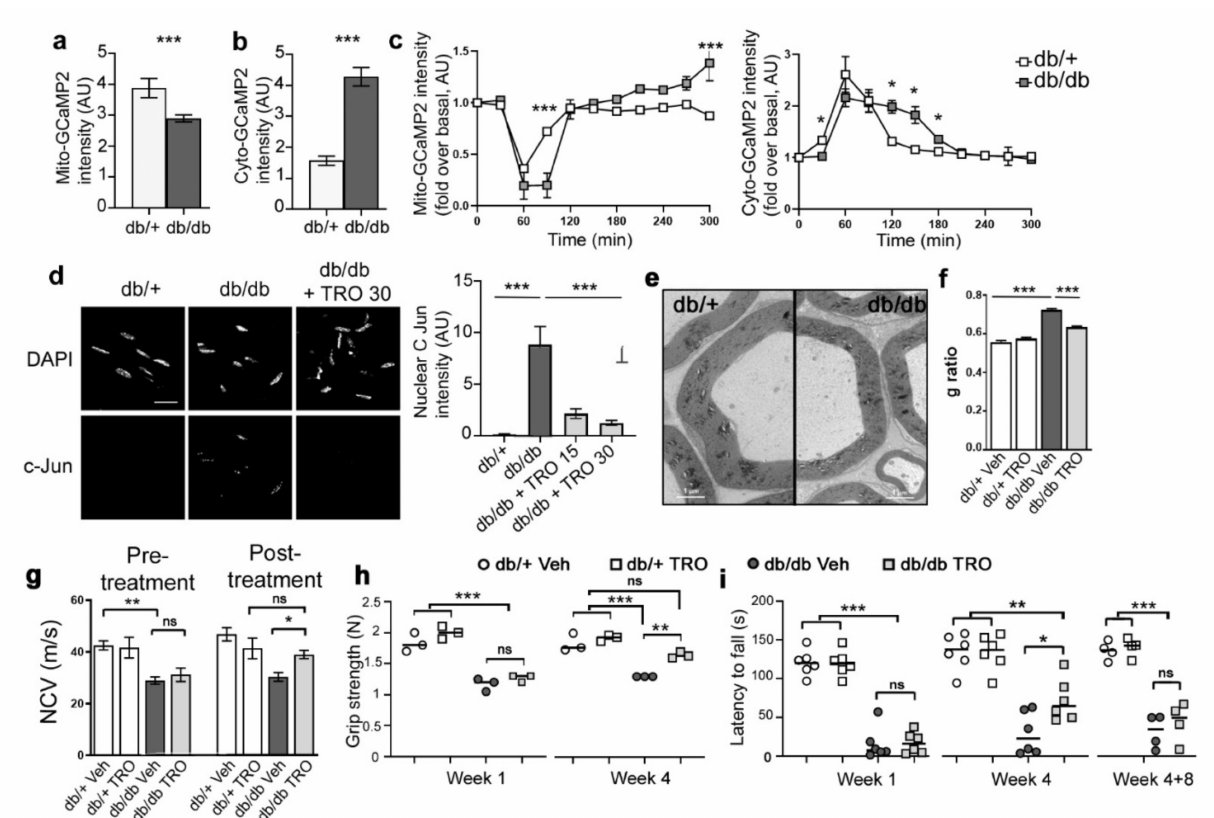
Figure 7. SCs of db/db diabetic mice show an altered mitochondrial calcium homeostasis and TRO19622 prevents motor, electrophysiological and cellular defects in these mice. Mitochondrial calcium (Mito-GCaMP2) ( a ), cytoplasmic calcium (Cyto-GCaMP2) ( b ) probe intensity in mSCs of control ( db/+ ) and diabetic ( db/db ) mice in basal conditions. Mitochondrial calcium is decreased and cytoplasmic calcium increased in the mSCs of diabetic mice. Error bars indicate SEM. Statistical tests are unpaired Student’s t -test. ( a ) n = 77 ( db/+ ), 168 ( db/db ) mitochondria (6 animals each genotype). ( b ) n = 11 ( db/+ ), 9 ( db/db ) mSCs (3 mice each genotype). All mice were 8 to 11 weeks old. ( c ) Mito- chondrial calcium (left) and cytoplasmic calcium (right) probe intensity in mSCs of control ( db/+ ) and diabetic ( db/db ) mice following nerve crush (t = 0). Mitochondrial calcium release is significantly sustained at t = 90 min. The probe fluorescence intensity is normalized over the basal condition before crush. Error bars indicate SEM. Statistical tests are two-way ANOVA Sidak post hoc test. Left: n = 40 ( db/+ ), 88 ( db/db ) mitochondria (3 mice for each genotype). Right: n = 7 ( db/+ ), 5 ( db/db ) mSCs (3 mice for each genotype). All mice were 8 to 11 weeks old. ( d ) Left panel: Immunohistochemistry for phospho–c-JUN and DAPI nuclei staining on mouse sciatic nerve cryosections. Mice were treated with vehicle (db/+, db/db ) or with TRO19622 ( db/db + TRO 30, 3 mg/kg) for 30 days. Arrows indicate infected mSC nuclei. Scale bar: 50 µ m. Same magnification for all pictures. Right panel: Quantifica- tion of nuclear phospho–c-JUN represented as fold over db/+ mice. Noninfected neighbour cells were used as internal controls. Mice were treated with vehicle (db/+, db/db , 30 days) or with TRO19622 for 15 days ( db/db + TRO 15) or 30 days ( db/db + TRO 30). Error bars indicate SEM. Statistical tests are one-way ANOVA test. n = 28 (db/+), 17 ( db/db ), 17 ( db/db + TRO 15), 19 ( db/db + TRO 30) cells (3 mice of each condition). All mice were 8 to 11 weeks old. ( e ) Representative transmission electron micrograph images of sciatic nerve cross sections of db/+ and db/db mice. Scale bar: 5 µ m. ( f ) g ratio (axon diameter/fiber diameter) was measured on electron micrograph from db/+ or db/db mice treated with vehicle (db/+ Veh, db/db Veh) or TRO16922 for 30 days (db/+ TRO, db/db TRO) (3 mg/kg). A minimum of 189 fibers was measured per animal. Statistical test is one-way ANOVA followed by a Dunnett’s multiple comparison post-hoc test. n = 3 mice for each condition. ( g ) Measure of sciatic nerve NCV of db/+ and db/db mice before and after treatment with vehicle (db/+ Veh, db/db Veh)